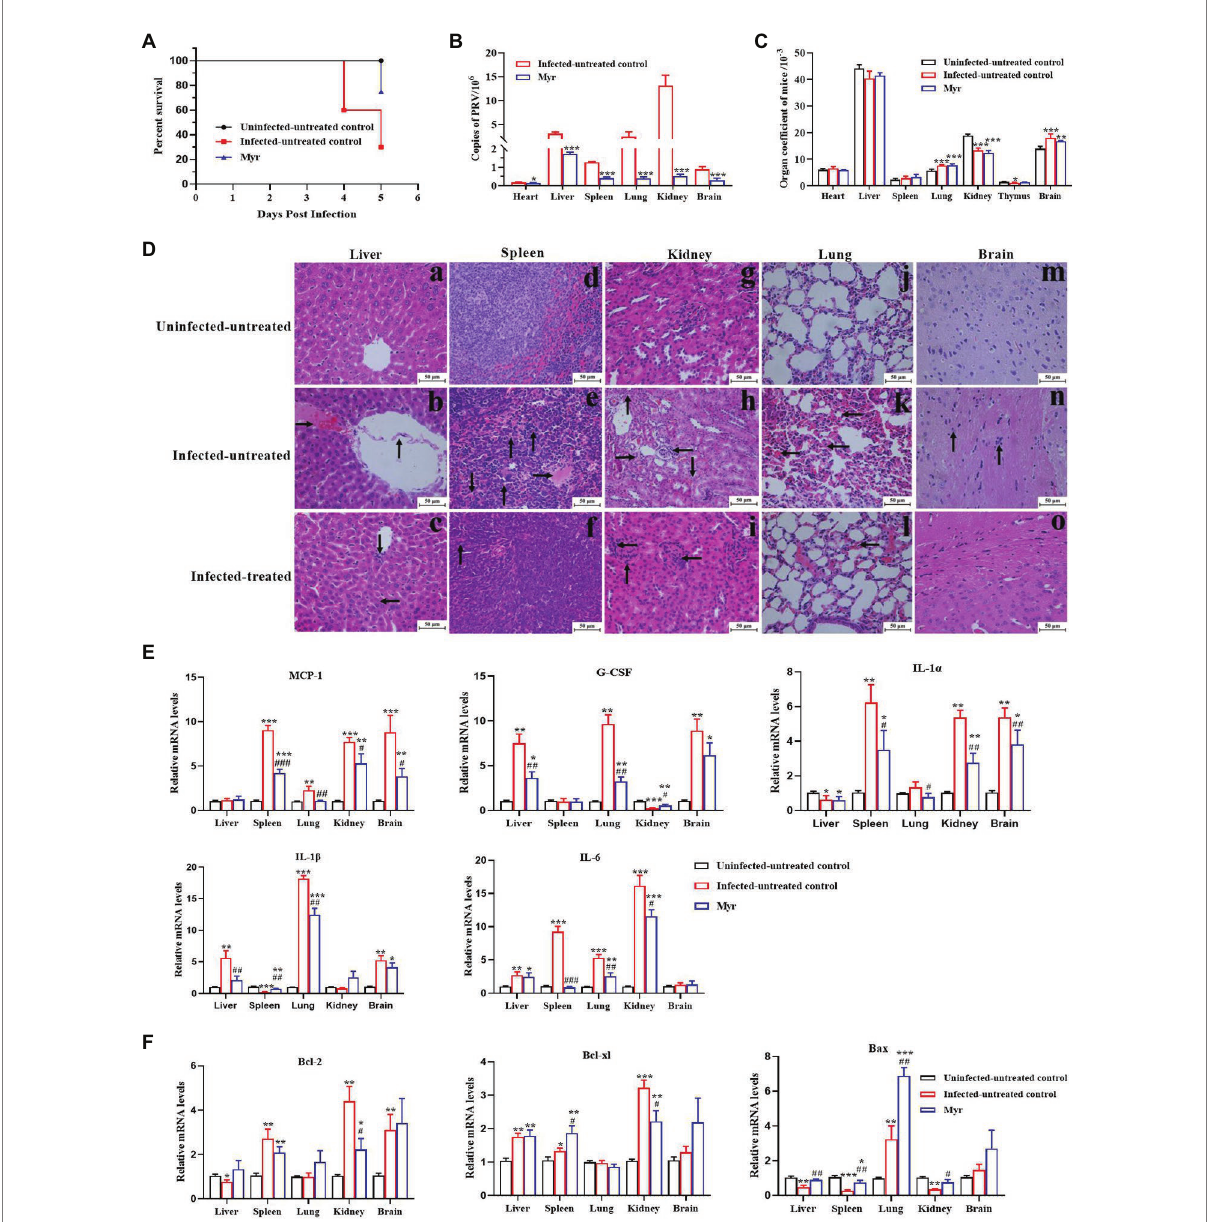
FIGURE 7 Antiviral activity of myricetin in PRV-infected mice. (A) The survival rate of mice in each group depicted by Kaplan–Meier survival plots. The survival rate = number of surviving mice/total number of mice. (B) Virus load of liver, spleen, lung, kidney, and brain in each group ( n = 3). The organs were frozen with liquid nitrogen, followed by homogenization. Total DNA of tissue sample was extracted and viral copies were determined by FQ-PCR. (C) Organ coefficient of mice. The heart, liver, spleen, lung, kidney, thymus, and brain were collected and weighed after dissected. The organ coefficient (mg/g) = organ weight/body weight. (D) Histopathological examination. In the liver (a–c) , PRV infection caused disordered arrangement of hepatic cords, shedding of blood vessel walls (denoted by arrowhead “ ↑ ”), and forming a clot (denoted by arrowhead “ → ”); The main changes were clustering of lymphocytes (denoted by arrowhead “ ↓ ”) and necrosis of liver cells (denoted by arrowhead “ ← ”) after myricetin treatment. In the spleen (d–f) , PRV infection formed a clot (denoted by arrowhead “ → ”), bleeding (denoted by arrowhead “ ↓ ”) and hemosiderosis (denoted by arrowhead “ ↑ ”); after myricetin treatment, the main changes were hemosiderosis (denoted by arrowhead “ ↑ ”). In the kidney (g–i) , PRV infection caused cell granule denaturation (denoted by arrowhead “ ↑ ”), hyperemia (denoted by arrowhead “ → ”), hematolysis (denoted by arrowhead “ ↓ ”) and clustering of lymphocytes (denoted by arrowhead “ ← ”); after myricetin treatment, the main change was clustering of lymphocytes (denoted by arrowhead “ ← ”). In the lung (j–l) , PRV infection caused blood congestion and blood stasis in the alveolar septal capillaries (denoted by arrowhead “ ← ”); after myricetin treatment, alveolar congestion and blood stasis were alleviated. In the brain (m–o) , PRV infection caused the glial cells surrounding the neurons (denoted by arrowhead “ ↑ ”); no significant changes were detected after myricetin treatment. (E,F) Expression levels of inflammatory factors (E) and apoptotic factors (F) . Total RNA of different organs was extracted and reverse-transcribed for RT-PCR assay. All data are presented as mean ± SD, n = 3. Symbols “*, **, and ***” represent p < 0.05, p < 0.01, and p < 0.001, respectively, between the uninfected-untreated group and other groups. Symbols “#, ##, and ###” represent p < 0.05, p < 0.01, and p < 0.001, respectively, between the infected-untreated group and infected-treated